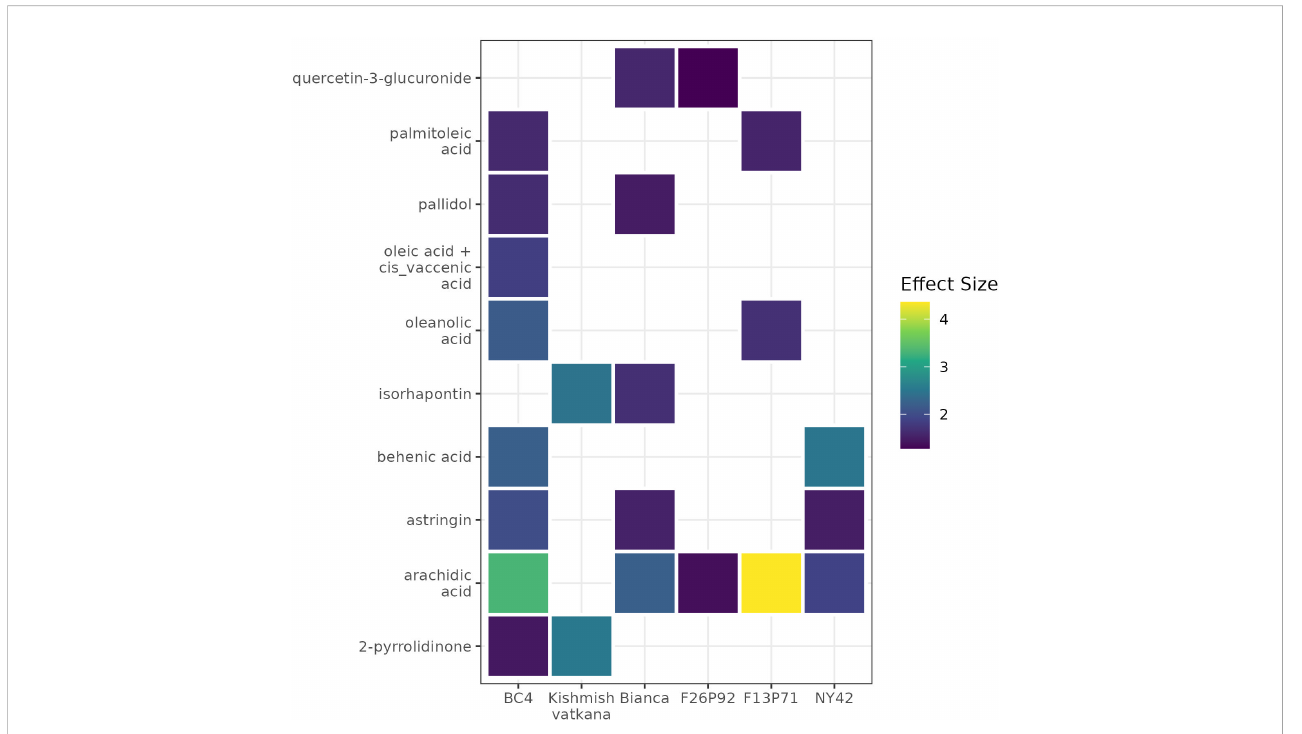
FIGURE 7 A heat map using color-encoded effect size of the discriminative compounds identi fi ed as present in the resistant genotypes and absent in the susceptible genotype at 48 hpi. The colors and their intensities mark the modulation of the metabolites in the resistant genotypes according to the calculated effect size (Cohen ’ s d